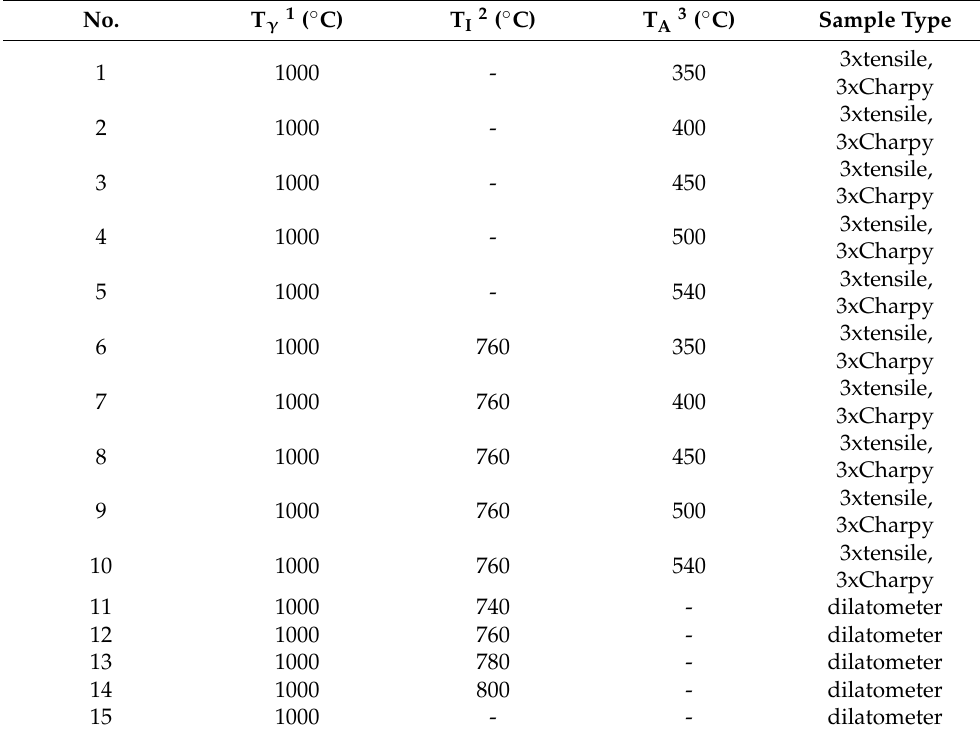
Table 2. Experimental